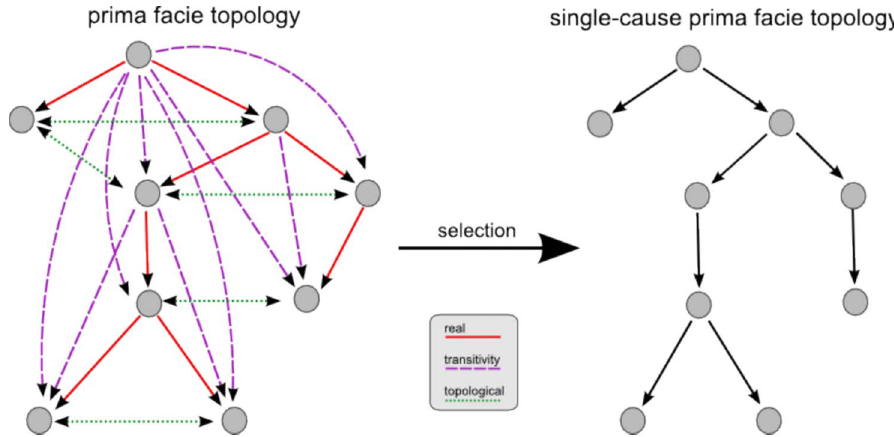
Figure 1. Prima facie topology. Example prima facie topology where all edges ( a , b ) represent prima facie causes, according to Definition 3: a is a probability raiser of b and it occurs more frequently. In left, we filter out spurious causes and select only the real ones among the genuine, yielding a single-cause prima facie topology.